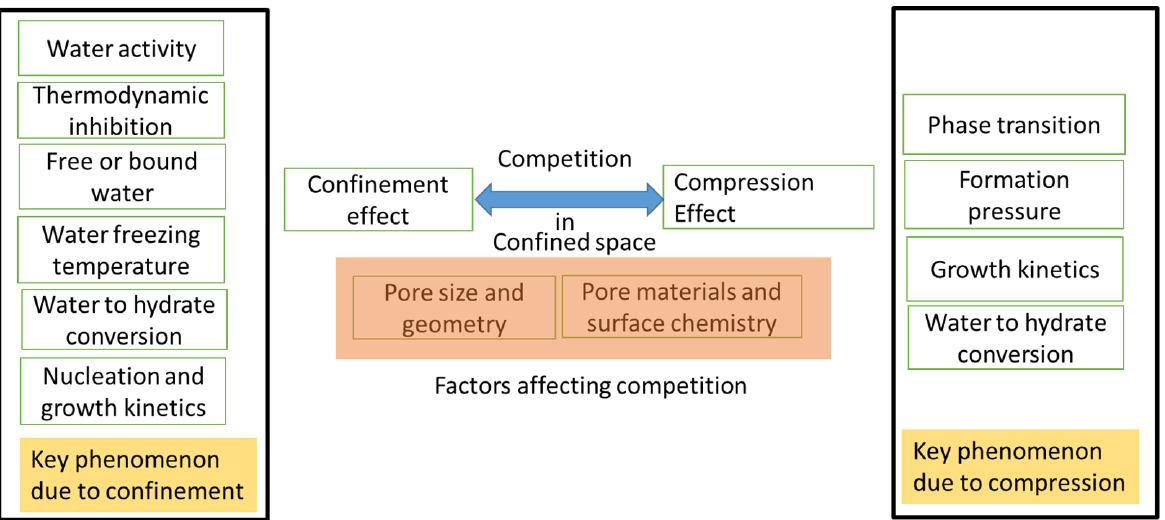
Figure 9. Proposed competition governing hydrate formation and growth kinetics in confined nano space.